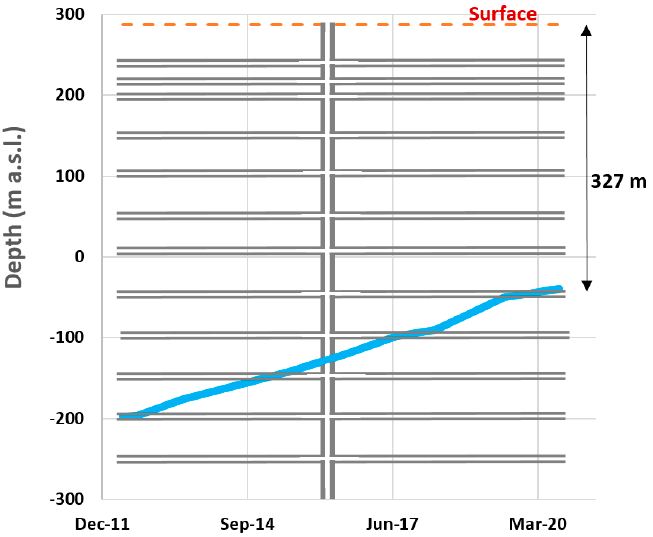
Figure 3. Groundwater rebound (flooding) in the Lieres mine.